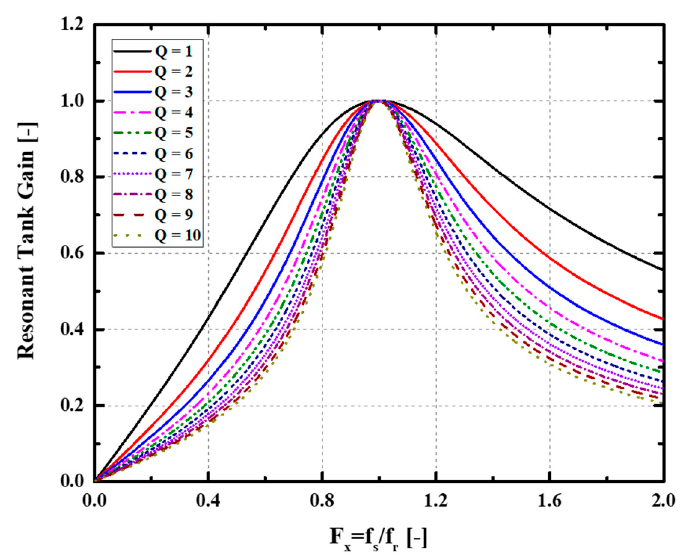
Figure 3. Resonant characteristic curve.